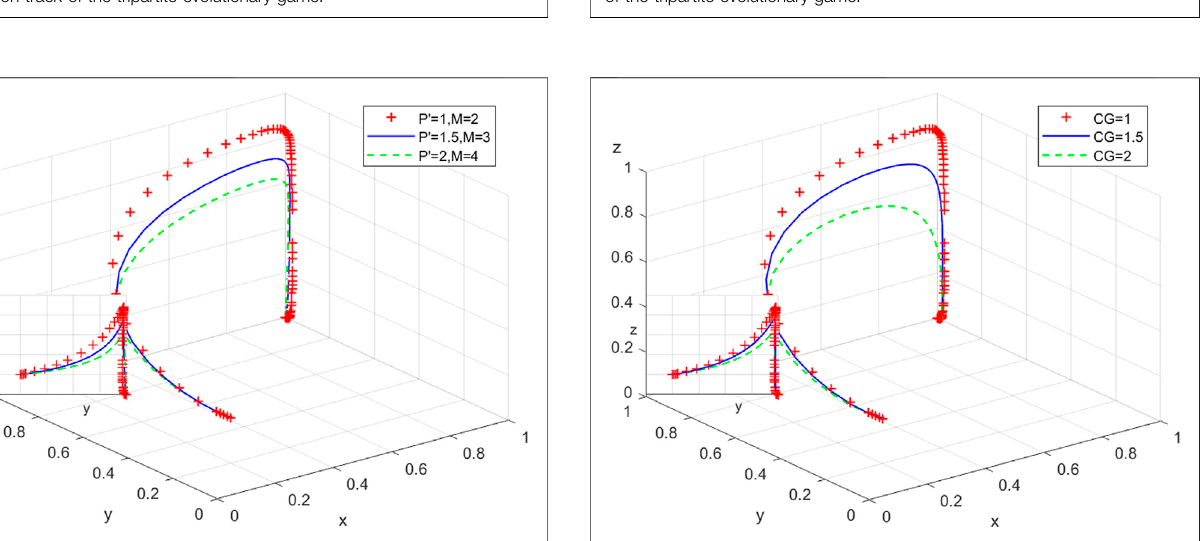
Frontiers in Environmental Science |